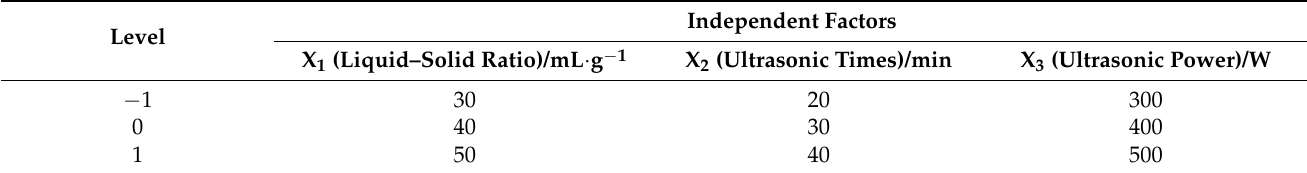
Table 1. Independent factor levels in